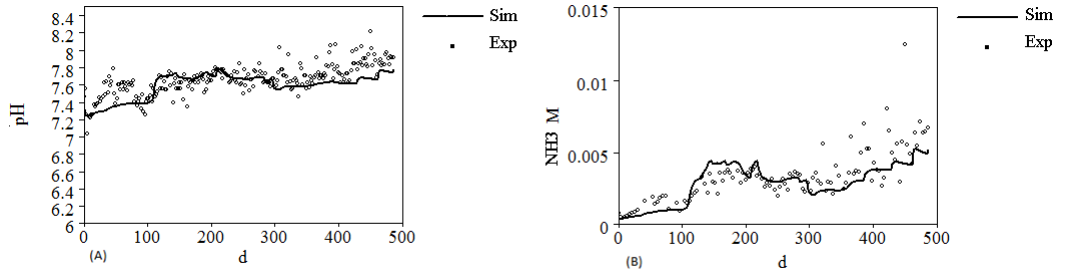
Figure 6: Simulated and experimental pH (A) and free ammonia concentration (B)